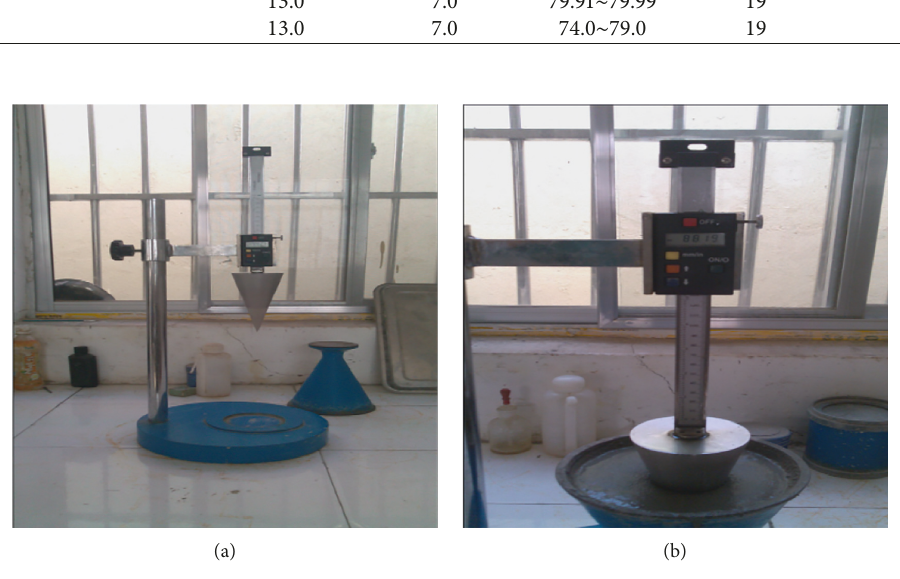
Figure 1: Consistency instrument.